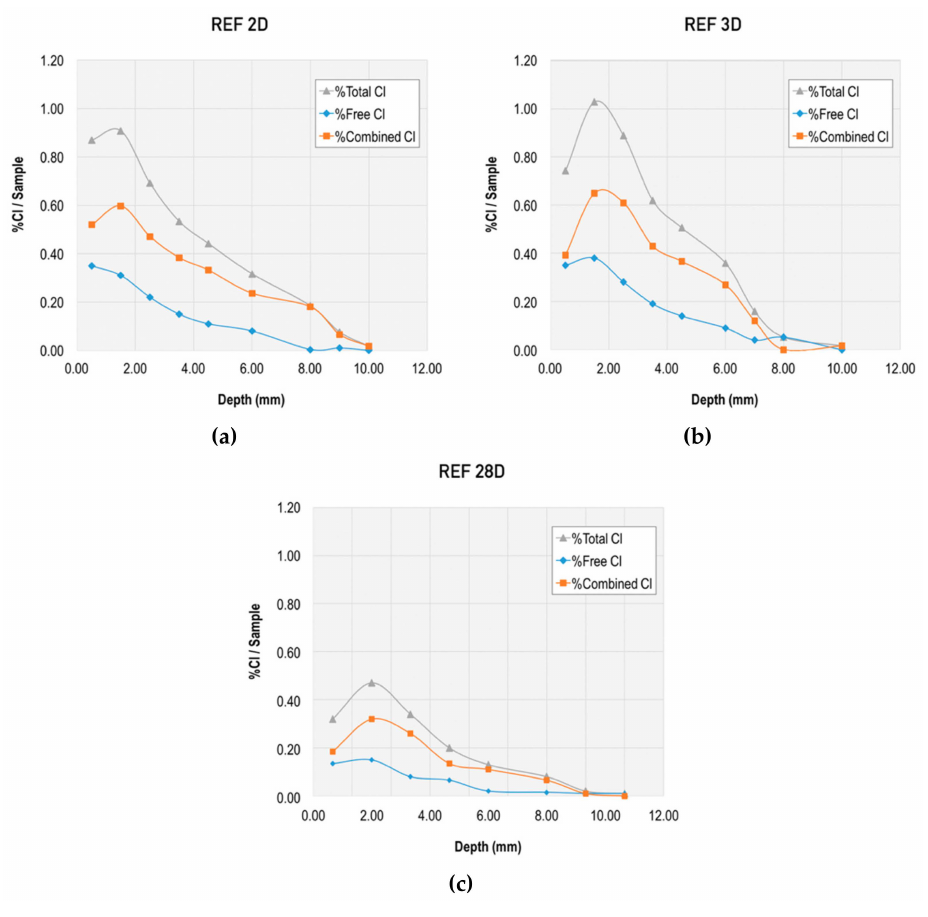
Figure 6. Total, free, and combined chloride content in reference mix at early ages: ( a ) at twodays, ( b ) at three days, and ( c ) at 28 days.